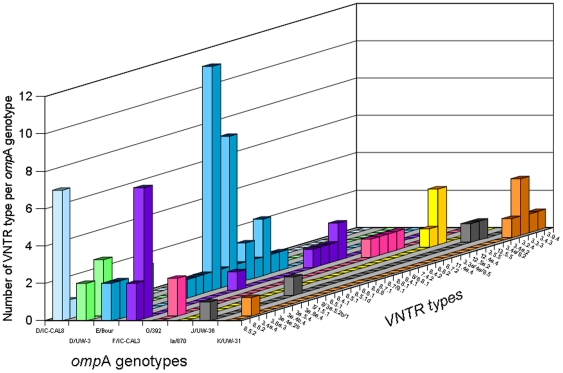
Distribution of different VNTR types according to ompA genotype (where loci appeared mixed in individual samples, both numerals are given separated by a ‘/’).